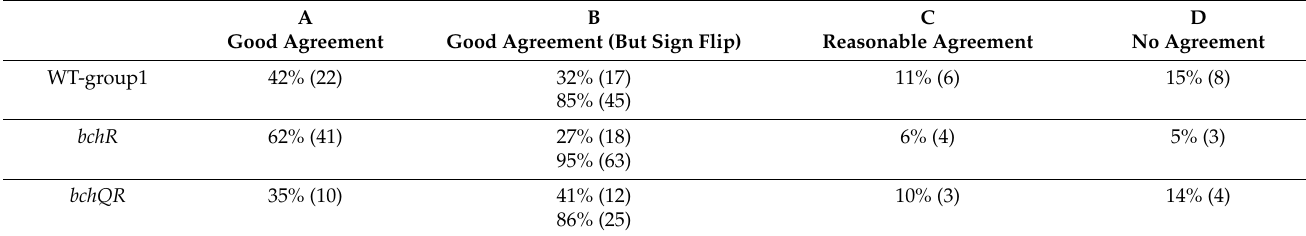
Table 1. Summary of the pairwise comparison of the single-chlorosome LD spectra that were reconstructed according to the two different protocols. The absolute number of complexes is given in